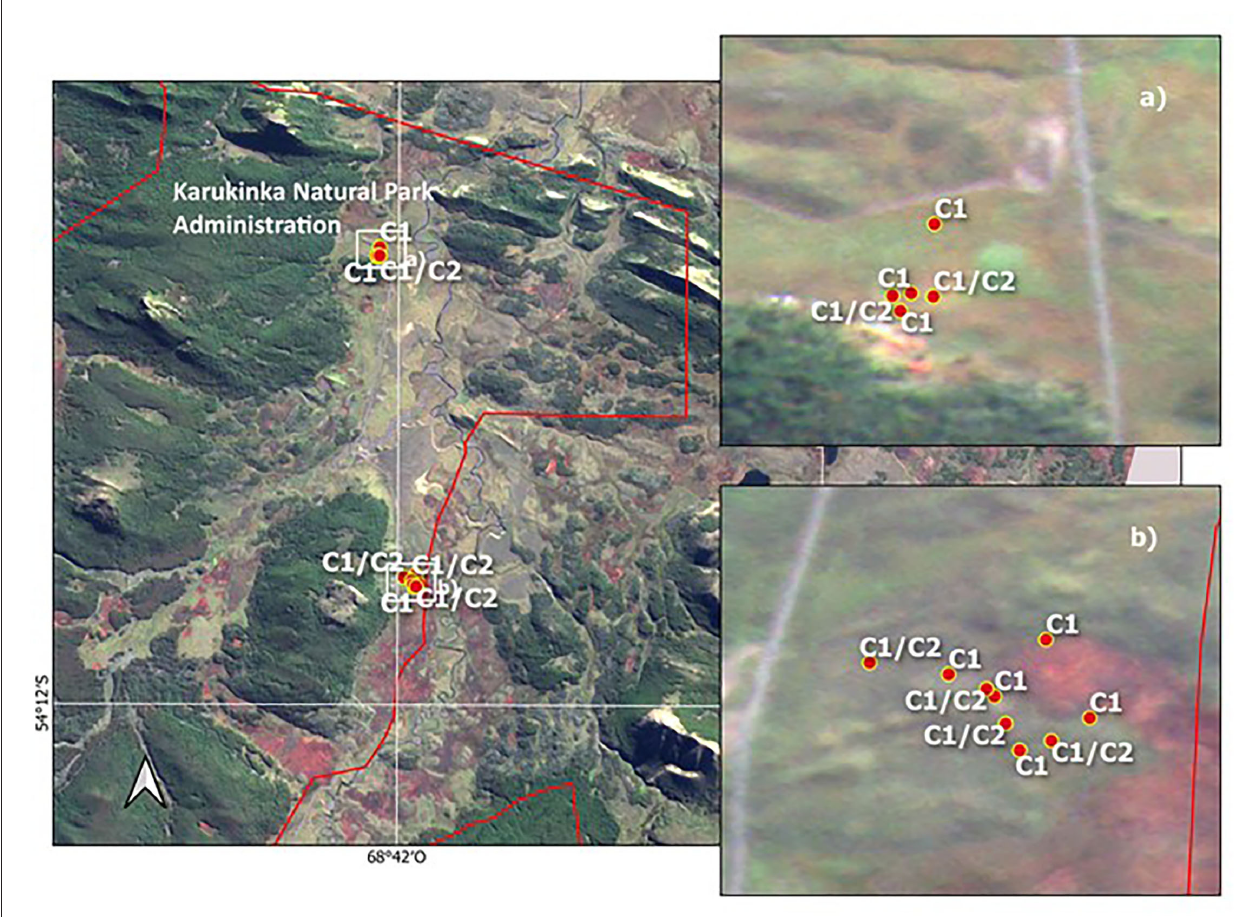
FIGURE 6 | Distribution of two Sanionia uncinata clusters found inside of Karukinka Natural Park, Southern Patagonia. The lines in red are the limits of the Park. (a,b) show zoom to sampling sites with C1 corresponding to Cluster 1 and C2 to Cluster